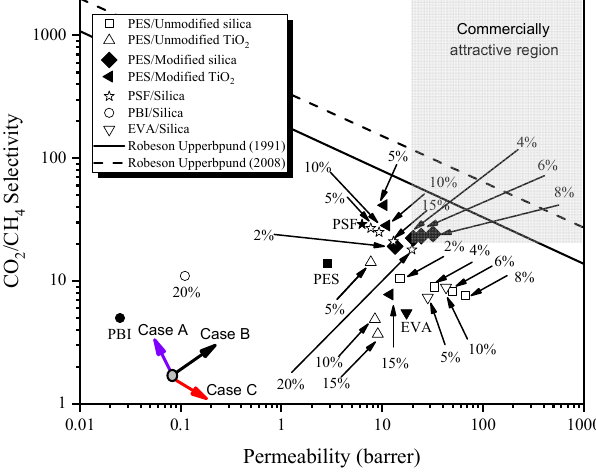
Figure 11. Comparison of MMMs on Robeson upper bound.